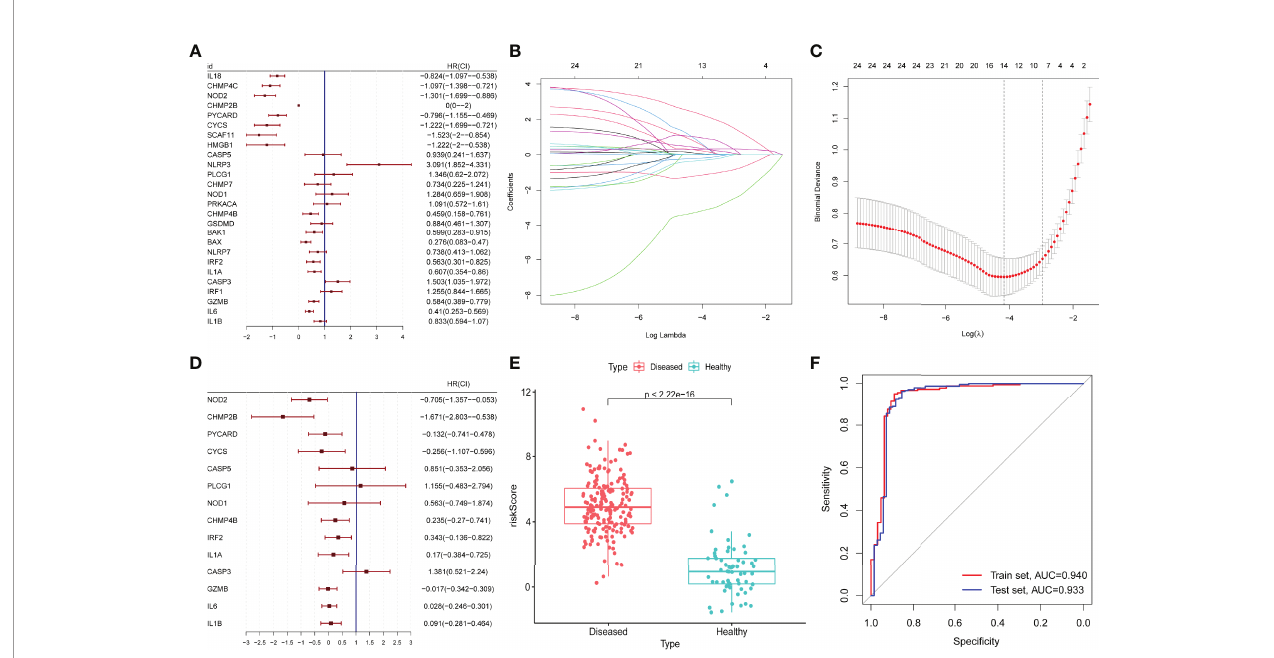
FIGURE 3 | Construction and validation of a prognostic model. (A) Univariate logistic regression analysis for the 26 differentially expressed pyroptosis-related genes (PRGs) in periodontitis samples (GSE10334) with P < 0.05. (B, C) A total of 14 prognostic genes were selected among 26 periodontitis-related PRGs with least absolute shrinkage and selection operator (LASSO) model, selecting the optimum parameter ( l ) as 14 with 10-fold cross-validation. (D) Multivariate logistic regression for the 14 prognostic PRGs. (E) Risk scores of the disease (periodontitis) and healthy samples in the GSE10334 dataset ( P < 2.2E-16). (F) Receiver operating characteristic (ROC) curve of the GSE10334 dataset (training set) and the GSE16134 dataset (test set). The area under the curve (AUC) value of the train set and the test set is 0.940 and